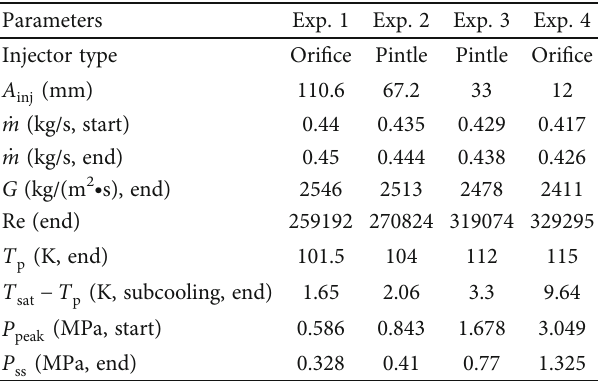
Table 1: Experimental conditions and results.